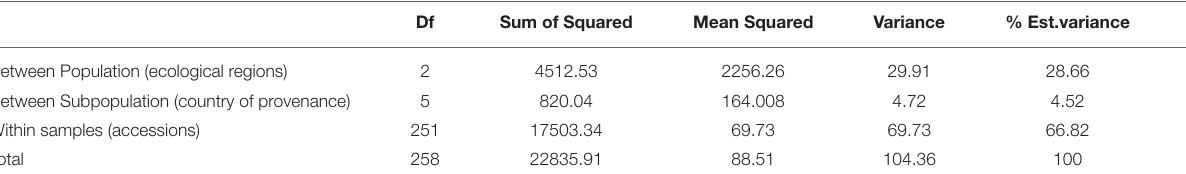
TABLE 4 | Analysis of molecular variance (AMOVA) results.